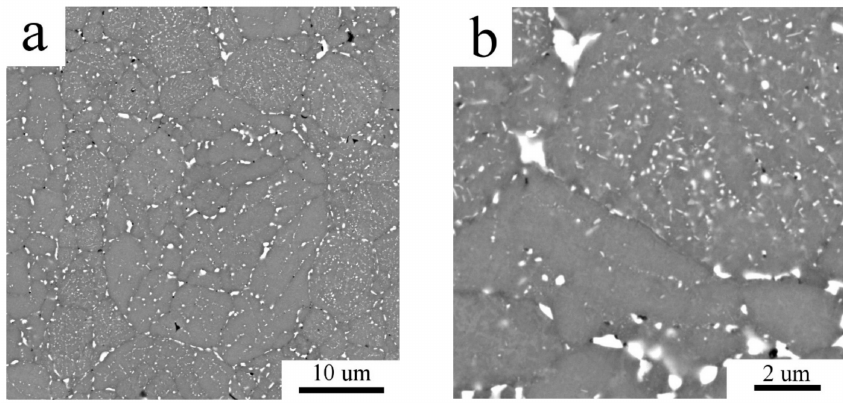
Figure 5. The microstructure of the Al7075_AC compact: ( a ) BSE contrast image; ( b ) detail of the BSE contrast image, SEM.